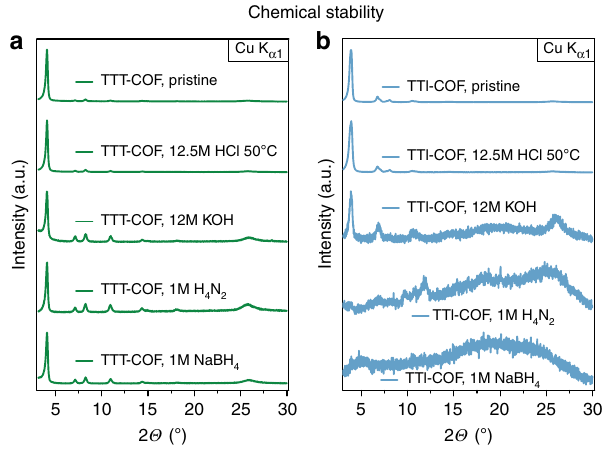
Fig. 4 Chemical stability tests of the TTI- and TTT-COFs. Stability is judged by the crystallinity of the frameworks after exposure to various aggressive chemicals. The TTI- and TTT-COF samples were each exposed to identical conditions for 16 h, which showed a substantially higher stability of the TTT-COF ( a ) against reactive conditions than the corresponding